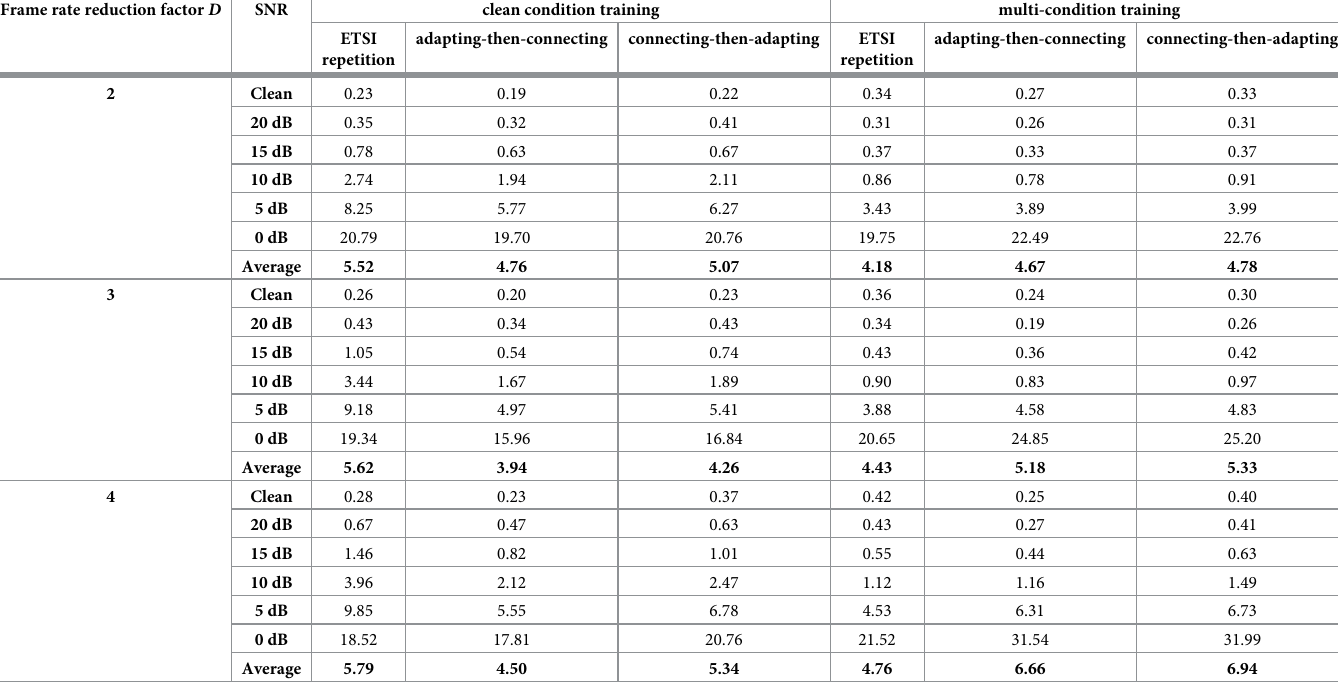
Table 3. Deletion error rate for the ETSI repetition and the two adaptation